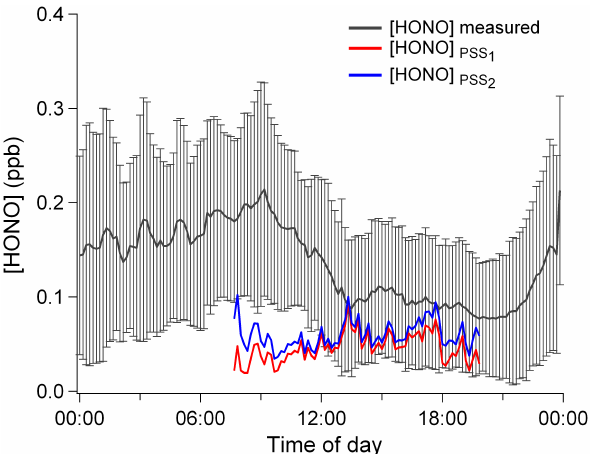
Fig. 6. Mean diurnal profiles of observed HONO mixing ratios (black lines) and HONO mixing ratios calculated using PSS calcu- lation (red line for Eq. 1 and blue line for Eq. 2) for the MEGAPOLI summer campaign. Error bars correspond to standard deviation for day to day variability of measurements (local